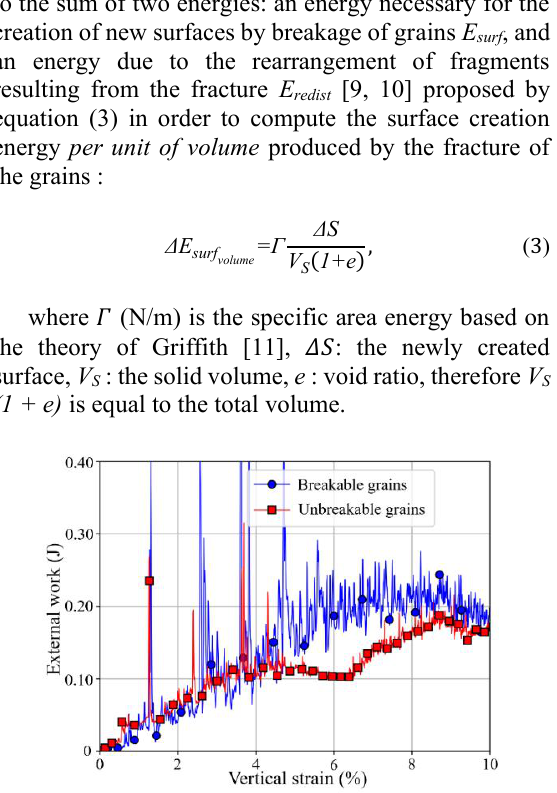
Fig. 5 . Evolution of the external work during the oedometric compression of samples of breakable and unbreakable grains.